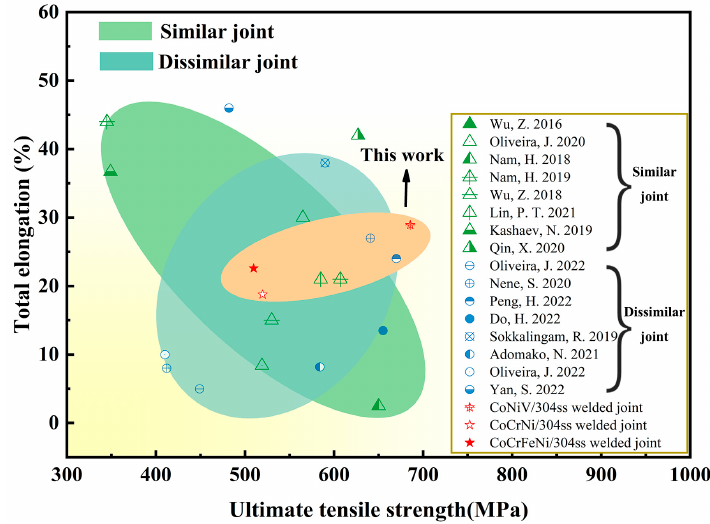
Figure 10. Statistics of mechanical properties of similar or dissimilar welded MCAs [12–